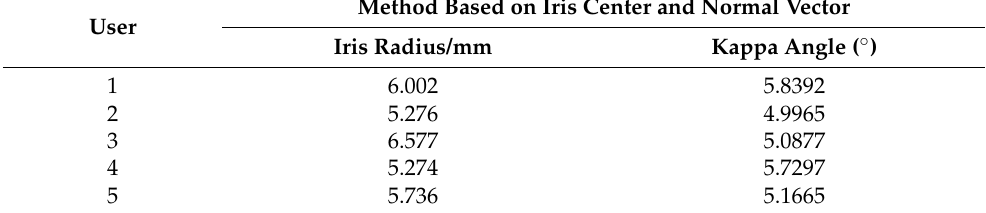
Table 7. User calibration